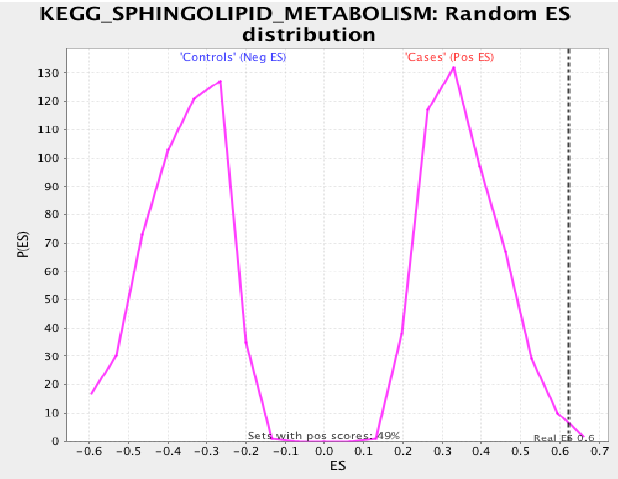
Figure 7. Null distribution of enrichment scores in the sphingolipid metabolism pathway in cases versus controls.